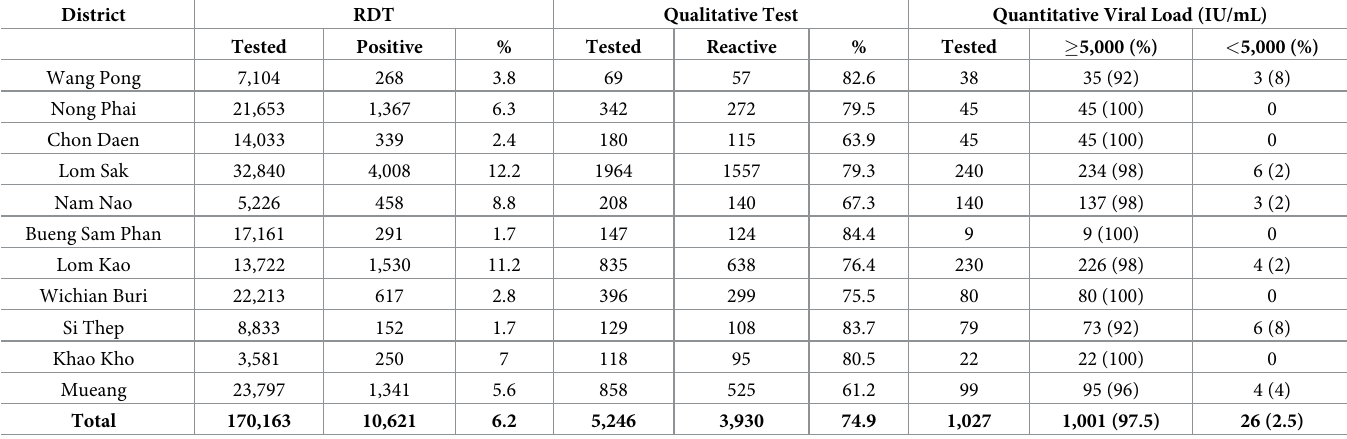
Table 2. HCV screening and confirmatory tests in 11 districts of Phetchabun.